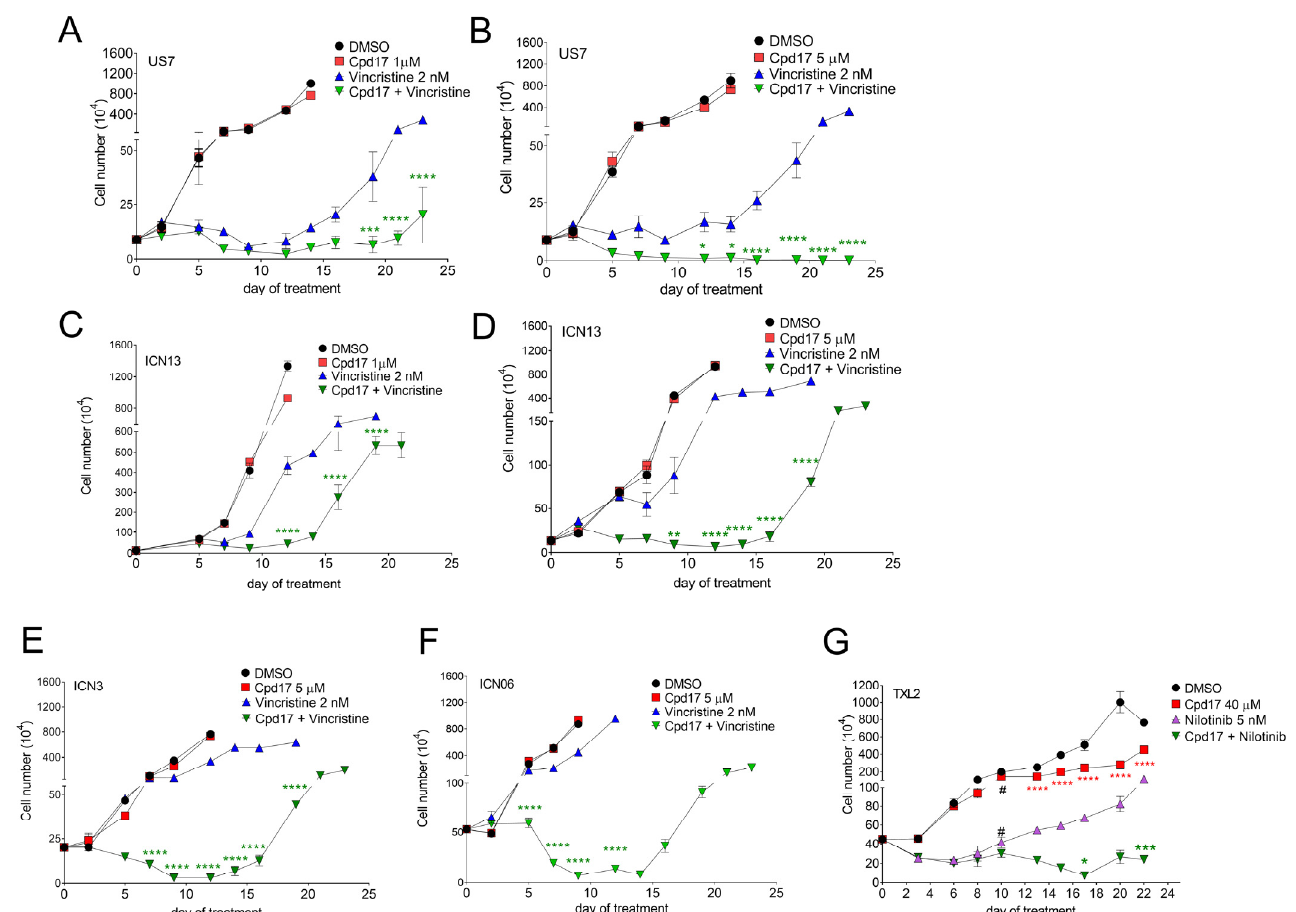
Figure 8. Proliferation of BCP-ALLs under combination treatment with Cpd17. Cells were treated with DMSO, mono-treatment or combination as indicated. Fresh drugs were added with each change of medium. Cell counts by Trypan blue exclusion in DMSO and Cpd17 groups were terminated (on day 12–14 for DMSO and Cpd17-only samples, later in vincristine-only resistance) when growth exceeded well capacity in panels A–F. Results presented are average of three replicates +/ − SD of one experiment. Note the discontinuity of the Y -axis. ( A ) US7 treated with 1 μ M Cpd17 and 2 nM vincristine. Vincristine alone or vincristine + Cpd17 compared to DMSO, significantly different starting at d7 (not indicated in the figure). ( B ) US7 treated with 5 μ M Cpd17 and 2 nM vincristine. Vincristine alone or vincristine + Cpd17 compared to DMSO, significantly different starting at d9. ( C ) ICN13 treated with 1 μ M Cpd17 and 2 nM vincristine. Vincristine alone or vincristine + Cpd17 compared to DMSO, significantly different starting at d7. Vincristine compared to vincristine + Cpd17 significantly different on d9 and d12 as indicated in the figure [green asterisk]. ( D ) ICN13 treated with 5 μ M Cpd17 and 2 nM vincristine. Vincristine alone or vincristine + Cpd17 compared to DMSO, significantly different starting at d5. Also significant differences between vincristine alone and vincristine + Cpd17 on d5, d7, d9 and d12 as indicated. ( E ) ICN3 treated with 5 μ M Cpd17 and 2 nM vincristine. Difference between DMSO and vincristine alone or vincristine + Cpd17 significant starting from d9. Vincristine alone and vincristine + Cpd17, significantly different on d5, d7, d9, d12 [green asterisk]. ( F ) ICN06 treated with 5 μ M Cpd17 and 2 nM vincristine. Vincristine alone and vincristine + Cpd17, significantly different on d5, d7, d9 [green asterisk]. ( G ) TXL2 treated with 40 μ M Cpd17 and 5 nM nilotinib. Cpd17 was administered at 10 μ M on day 0, increased to 20 μ M on day six and further increased to 40 μ M on day 10 as indicated by #, because drug combination effects were minimal at 10 or 20 μ M. Nilotinib alone and nilotinib + Cpd17, significantly different from DMSO starting at d6. Nilotinib compared to nilotinib + Cpd17 significantly different on d17, d22 [green asterisks]. Cpd17 compared to DMSO different from d13 -d23 [red asterisks]. Panel G: 2-way ANOVA, Tuk- ey’s multiple comparison test. Panels A-F: 2-way ANOVA, Šidák’s multiple comparison test for vincristine versus vincristine + Cpd17; adjusted p -values. * p < 0.05, ** p < 0.01, *** p < 0.001, **** p < 0.0001. Similar to US7, the growth of ICN13 was not affected by 1 or 5 μ M Cpd17 (Figure 8C,D). Cell division of ICN13 was inhibited less than US7 by treatment with 2 nM vin- cristine. However, also with this BCP-ALL, the combination of Cpd17 with vincristine